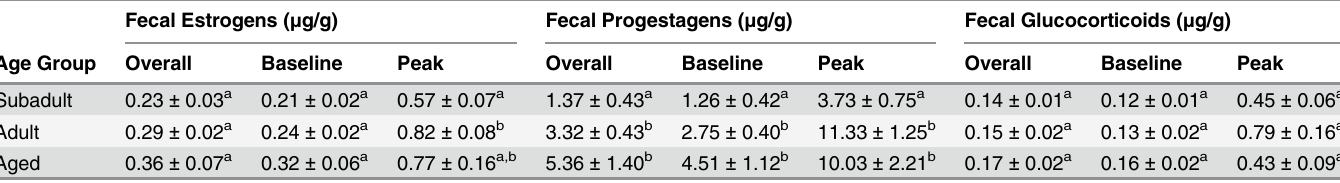
a,b,c Within column, differing letter superscripts indicate a signi fi cant difference ( P <